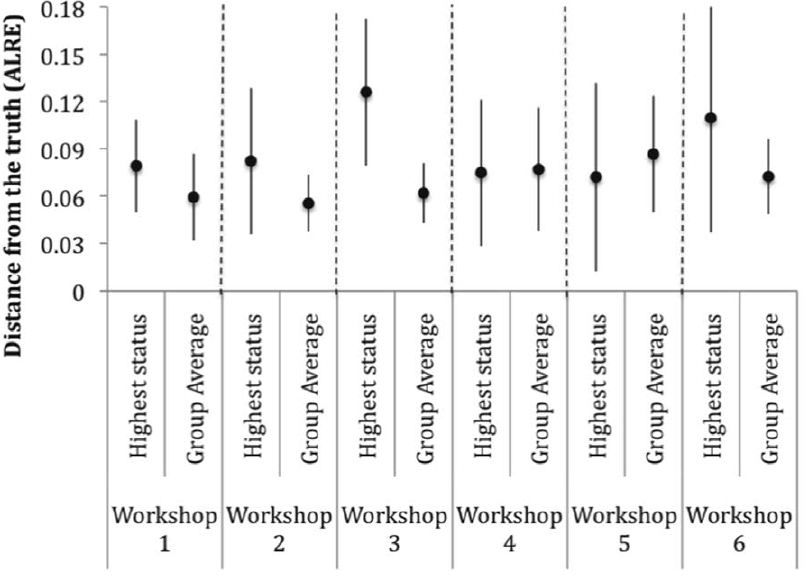
Figure 4. Accuracy of group means compared to highly regarded experts. Mean and 95% confidence intervals of standardized distance from the truth (ALRE) for the most highly regarded individual in each workshop prior to discussion (‘Highest status’), and the workshop group average following discussion (‘Group Average’).